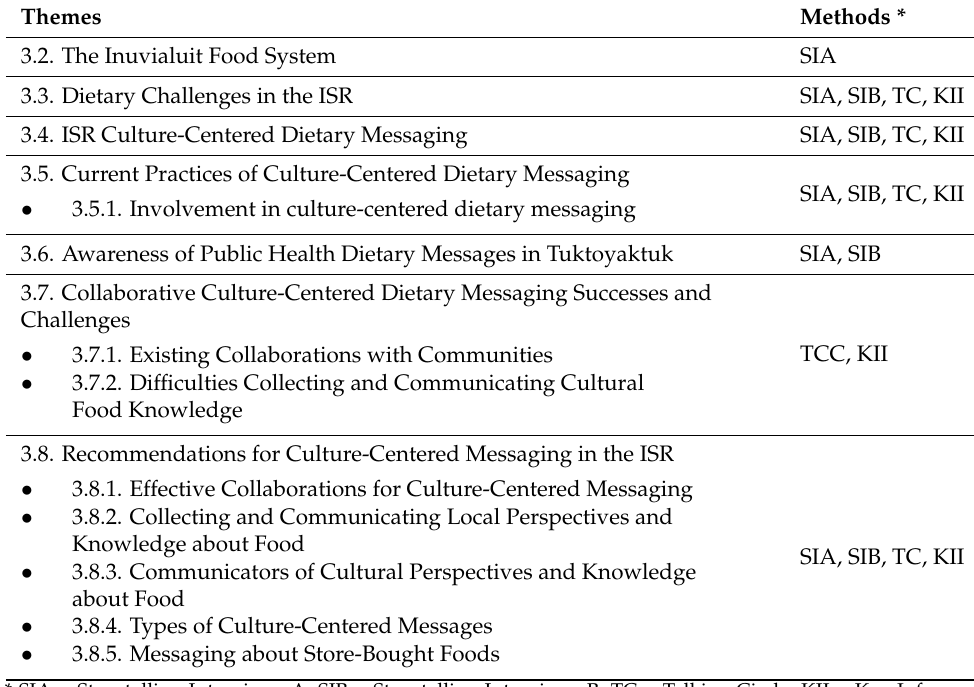
Table 1. Summary of major themes and sub-themes emerging from multiple research methods.